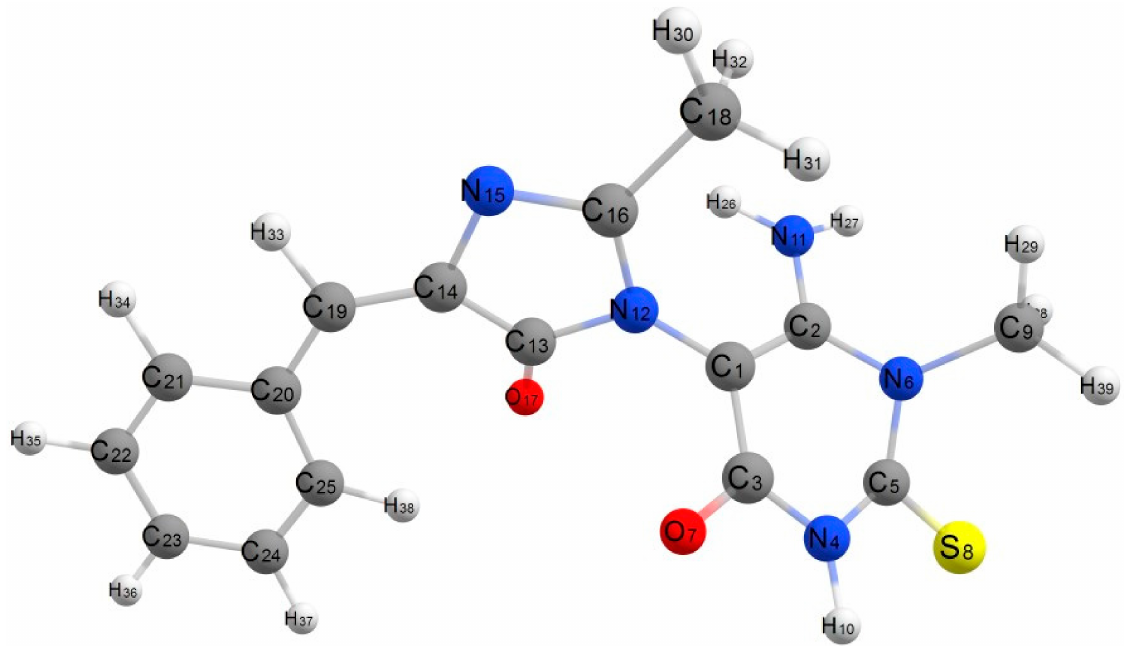
Figure 11. Optimized geometrical structure of compound 13 , 6-amino-5-(4-benzylidene-2-methyl-5-oxo- 4,5-dihydro-1 H - imidazol-1-yl)-1-methyl-2-thioxo-2,3-dihydropyrimidin-4(1 H )-one by using DFT